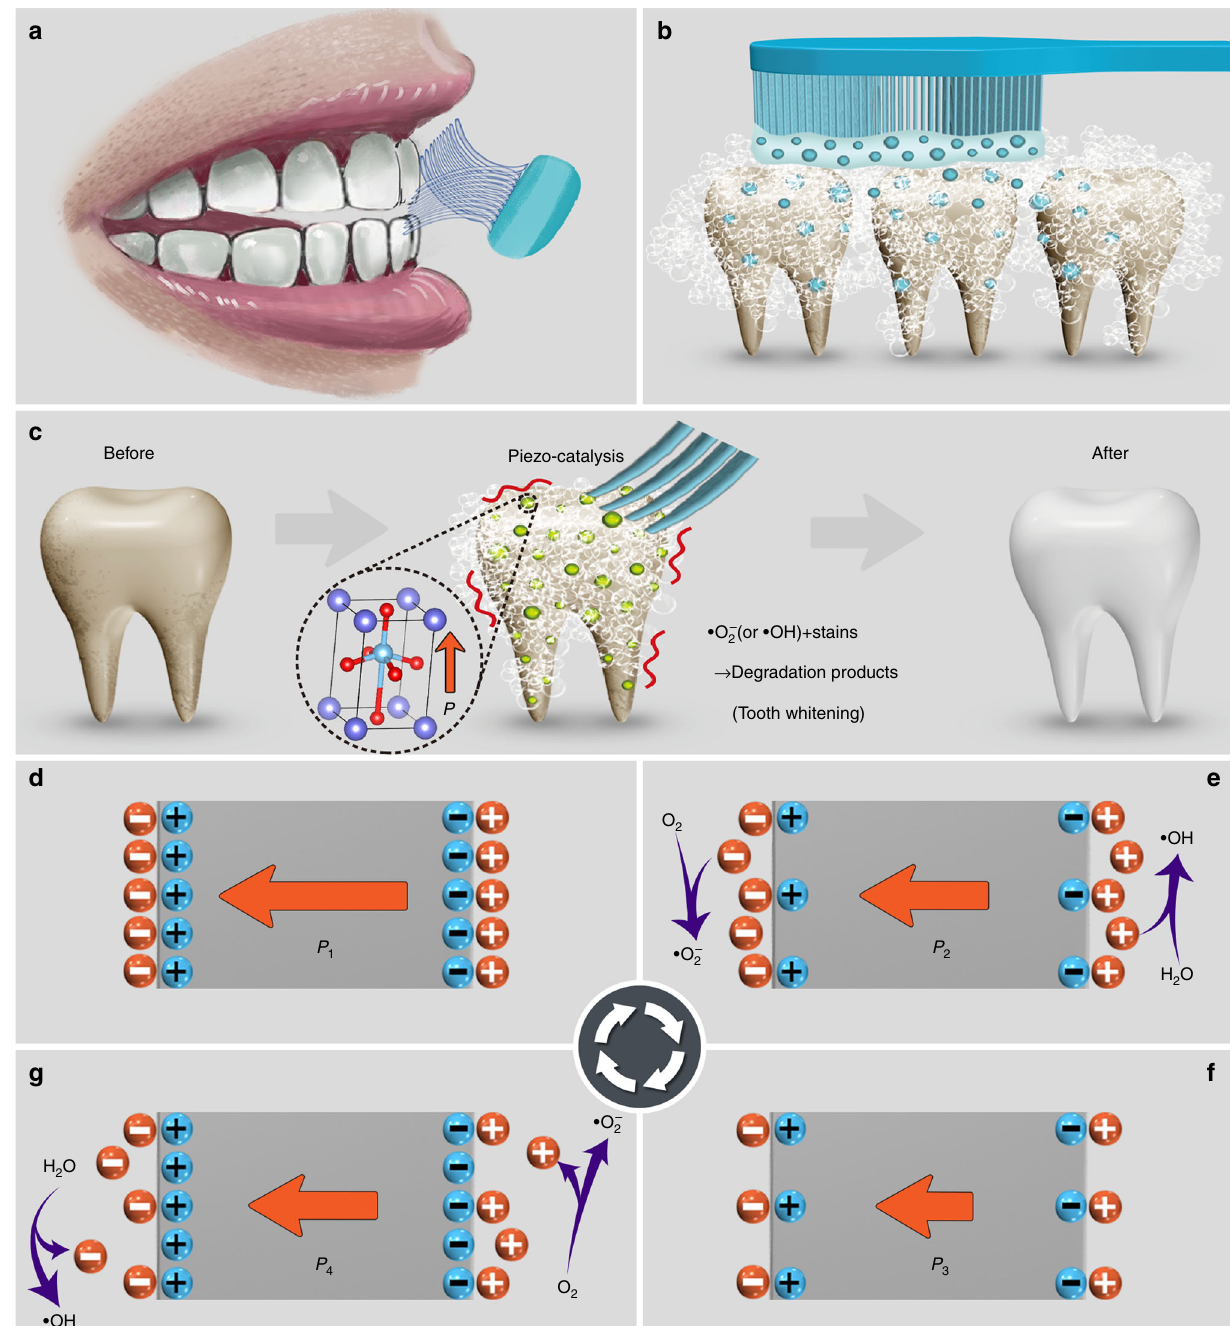
Fig. 1 Piezo-catalysis effect and working principle for tooth whitening. a Illustration of mechanical vibration between toothbrush and teeth during daily toothbrushing. b The traditional abrasive-based toothpaste method, where tooth whitening is realized by the mechanical friction between teeth and abrasive. c The proposed piezo-catalysis effect-based tooth whitening method wherein piezoelectric particles replace traditional abrasive in the toothpaste, to generate reactive oxygen species via piezo-catalysis to bleach tooth stains. The detailed mechanism of piezo-catalysis effect, i.e., d the original electrostatic balance state of a poled piezoelectric material; e the release of screening charges under compressive stress, which combine with water molecules and then produce reactive species; f the modi fi ed electrostatic balance state under maximum compressive stress; g the adsorption of charges from the surrounding electrolyte under reduced compressive stress. The charges in the electrolyte with opposite polarity to the adsorbed charges will participate in the redox reaction to produce reactive “ off ” state (i.e., generally regarded as the piezoelectric contribu- of piezoresponse force microscope are shown in Fig. 2f, g. The amplitude and phase signals of BTO nanoparticles show a clear tion) is shown in Fig. 2h, while the loop of “ On ” state is presented contrast relative to the silicon substrate, indicating that BTO in Supplementary Fig. 2. The phase angle shows a 180° change nanoparticles exhibit robust piezoelectricity and ferroelectricity. under a 50 V DC bias fi eld, revealing the ferroelectric polarization The local piezoelectric hysteresis loop of a BTO nanoparticle at switching process of BTO nanoparticles. The butter fl y-shaped